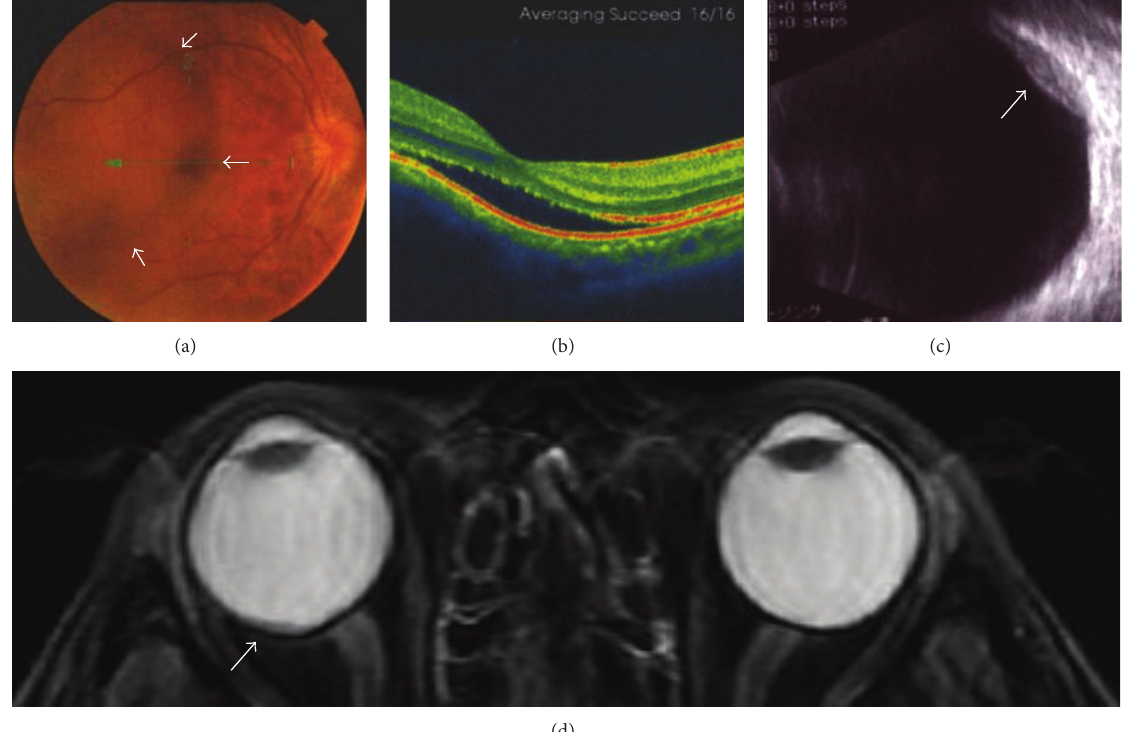
Figure 2: An elevated choroidal neoplasm. (a) Fundoscopic findings of the right eye demonstrating choroidal metastasis (arrows). (b) Optical coherence tomographic findings showing subretinal fluid in the inferior aspect of the lesion compromising the fovea. ((c) and (d)) Ultrasound and MRI T2-weighted images demonstrating an elevated choroidal mass